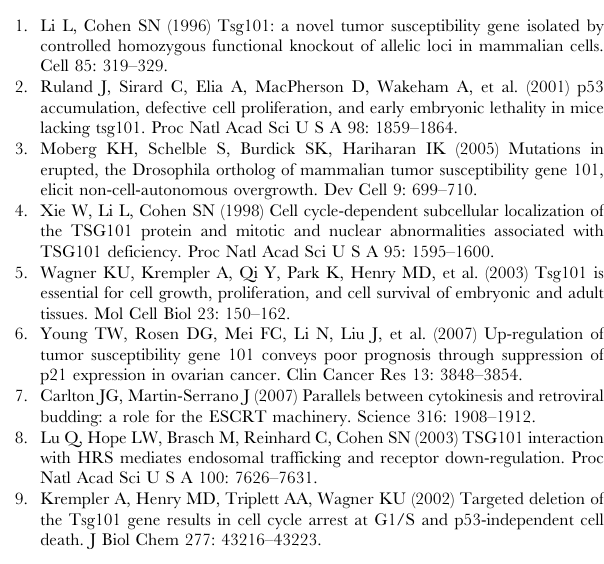
Table S1 Oligonucleotide primers used in Chromatin Immunoprecipitation (ChIP) and quantitative RT-PCR (qPCR). Table S2 List of genes that are statistically significant up-regulated or down-regulated in Saos-2-2 compared with its parental cells. Microarray data were deposited in GEO with an accession number GSE50808